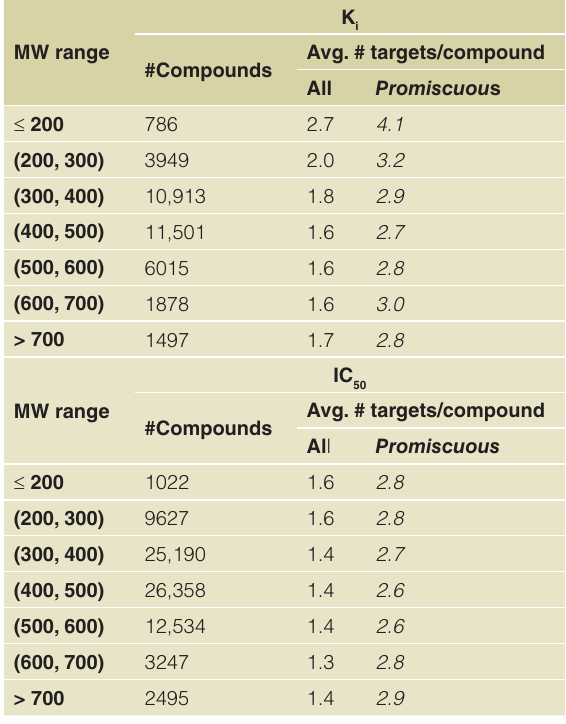
Table 6. Probability of promiscuity of compounds with different molecular weight.